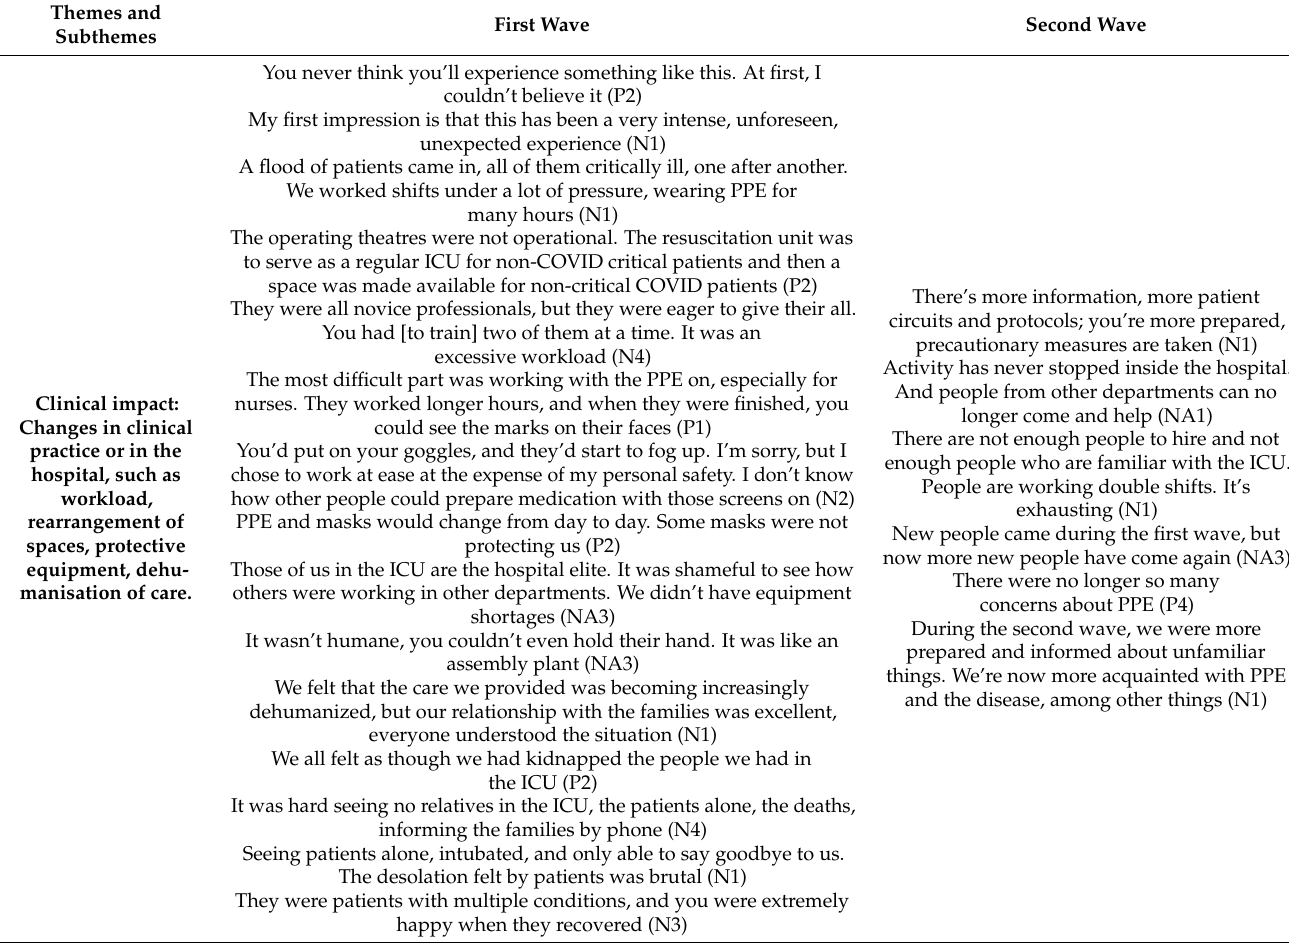
Table 6. Themes, subthemes, and representative quotes relating to the impact of